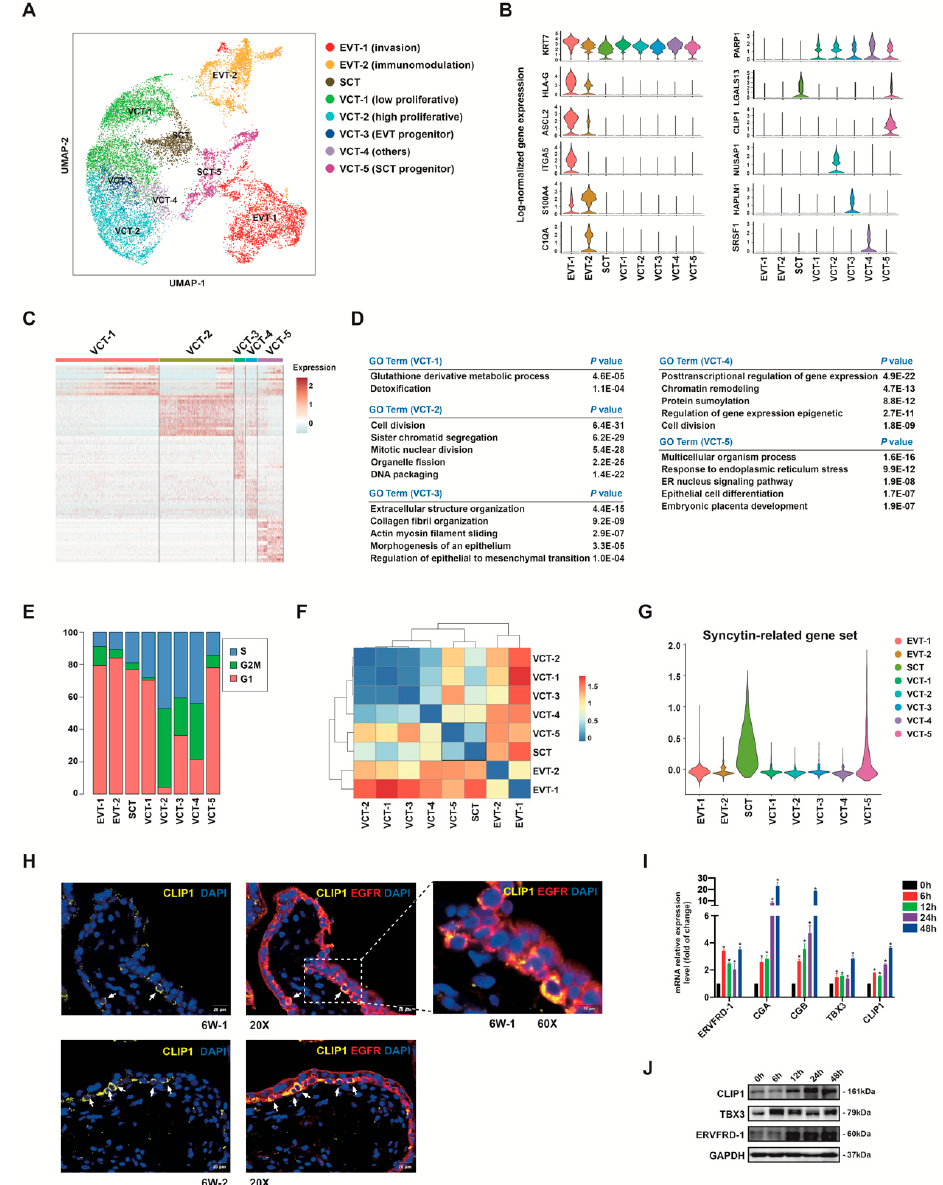
Figure 4. Cell subtype identification of human placental trophoblast cells. ( A ) UMAP plot showing eight subtypes of human placental trophoblast cells. ( B ) Violin plots showing the expression levels of representative marker genes across the eight clusters. Y -axis demonstrates log scale normalized read count. ( C , D ) Heatmap and GO enriched terms of cell type differentially expressed genes among the five VCT clusters. ( E ) Cell cycle analysis of eight trophoblast clusters. ( F ) Heatmap and the clustering structure show the dissimilarity across the trophoblast subpopulations. Blue color denotes the high similarity and red color denotes the low similarity. ( G ) Violin plots showing the expression levels of a representative syncytin-related gene set ( ERVFRD-1 , MFSD2A , ERVW-1 , ASCT1 , ASCT2 ) for each trophoblast cluster. ( H ) Immunofluorescence staining for the indicated VCT-5 marker CLIP1 and trophoblast marker EGFR in 6 weeks of gestation placenta. The white arrowheads indicate EGFR + CLIP1 + cells. Scale bars, 20 µ m. ( I , J ) In vitro analysis confirmed CLIP1 is induced under fusion differentiation conditions. BeWo trophoblast cells were exposed to differentiating conditions (50 µ M forskolin) for 0, 6, 12, 24, or 48 h. qRT-PCR ( I ) and Western blotting ( J ) showed the expression of CLIP1 and SCT marker genes mRNA and protein levels evaluated. * p < 0.05, n =